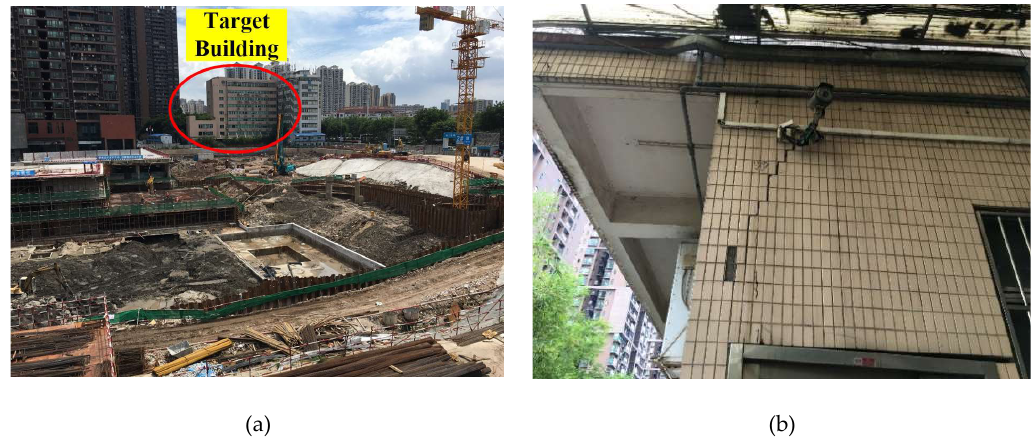
Figure 6. The differential deformation between the convergence points N (north) and S (south).